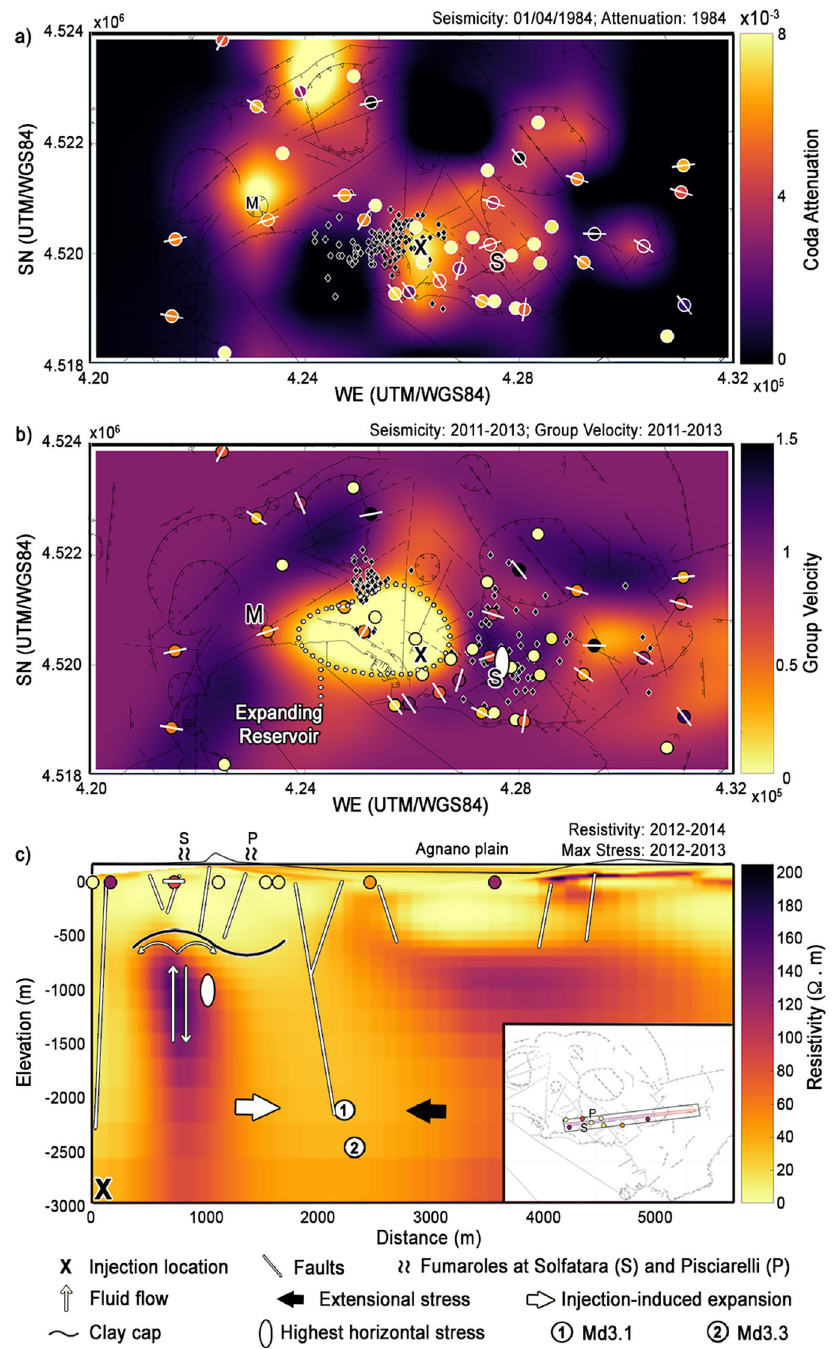
Fig. 2 Comparison of polarization with velocity, attenuation, resistivity and stress. a The low-frequency resultant lengths (colour-mapped in Fig. 1) and azimuths obtained at stations recording in 2009 and 2017 are compared with the high-attenuation signature (black cross, coda attenuation of 0.008 29 ) of the injections that opened the low-velocity hydrothermal system in 1984 16 . The black diamonds show the earthquakes recorded on April 1 st (maximum Md = 4.1) 16 . b In 2011-2013, a low-velocity aseismic reservoir was expanding from the injection location 6,35 (white dotted curve). The white ellipse at Solfatara is the point of highest lateral stress in 2011 – 2013 31 . The black diamonds show seismicity in the same period. c A resistive plume feeds the fumaroles at Solfatara and Pisciarelli. Faults and a clay cap 15 constrain the plume. The pro fi le and nearby seismic stations are shown inside the rectangle in the lower inset. The thick white arrow refers to the east-directed expansion 20,31 from the deep injection point. The thick black arrow shows the west-directed extension of the caldera-bounding faults 24 – 26 that bind a resistive metasomatic reservoir 15 under the Agnano plain. The Md3.1 and Md3.3 earthquakes 38 nucleate on a deep fault within conductive liquid-bearing metasediments 15 and polarized azimuths mark the NW-SE-trending extensional outgassing at the surface 28 (Fig. 1a, black dotted line). At higher faults with exceptional stability over years (Supplementary frequencies (1 – 5 Hz, Methods, Supplementary Fig. 1), regional and Figs. 2 – 3), months (Supplementary Figs. 4a – 5), days (Supplemen- caldera-bounding faults disappear due to the sensitivity of ambient tary Fig. 6), and even a single hour (Supplementary Fig. 4b) in noise to shallower and smaller structures 36 . High resultant lengths